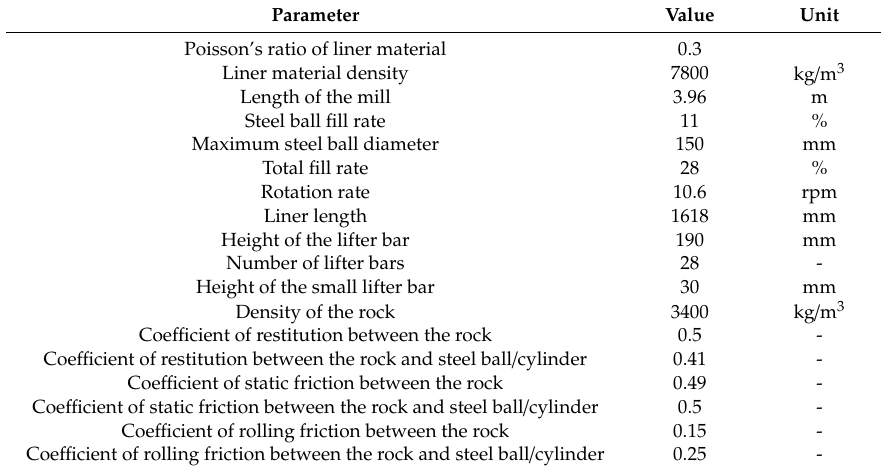
Table 1. Parameters of a semi-autogenous (SAG) mill liner’s wear in the